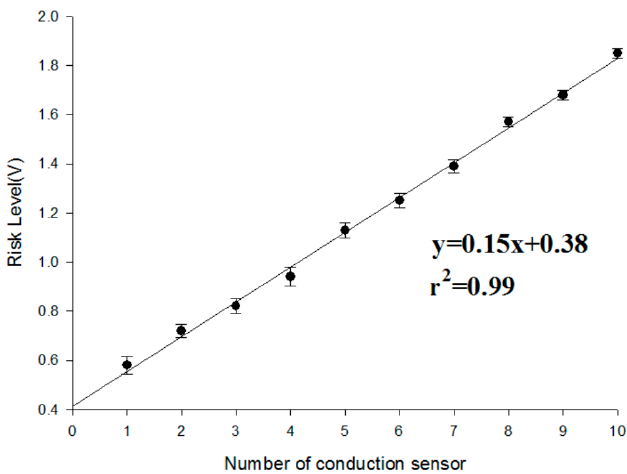
Figure 10. Experimental results for 10 individual conduction sensing points under the same weight ratio.